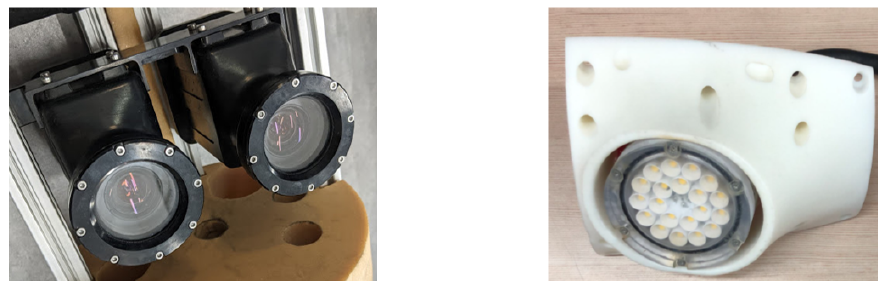
Figure 3. Stereo cameras inside the payload section ( left ) and rear strobe inside the tail section ( right